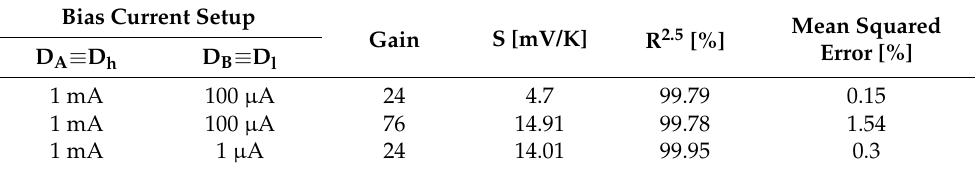
Figure 11. Simulated output voltage temperature dependence for the sensor system (dual-diode sensing element and readout circuit). Table 2. Sensor system